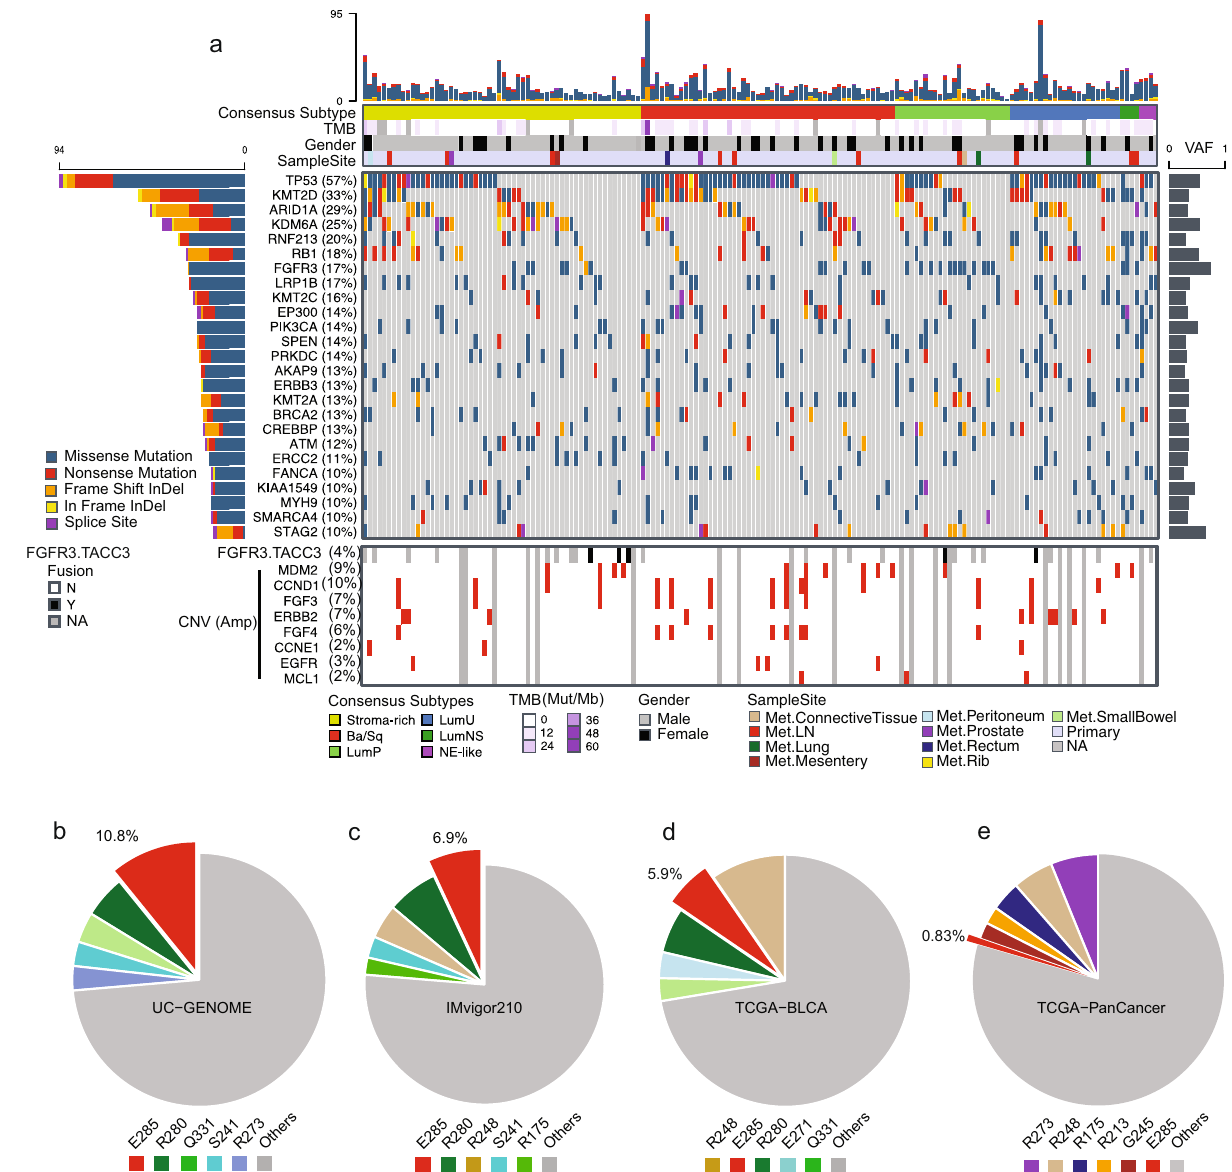
Fig. 2 | Targeted DNA sequencing analysis demonstrates a high prevalence of TP53 E285K mutations in UC. a Oncoplot of UC-GENOME bladder tumor samples sequence variant measurements, with annotation tracks for consensus subtype, tumor mutation burden (TMB), and gender. The top 25 genes based on frequency across samples of non-silent variants are shown. Percentages indicate number of tumor samples of total with an identi fi ed variant in each respective gene. Gene fusions and the most frequent focal ampli fi cations of those assayed (Methods